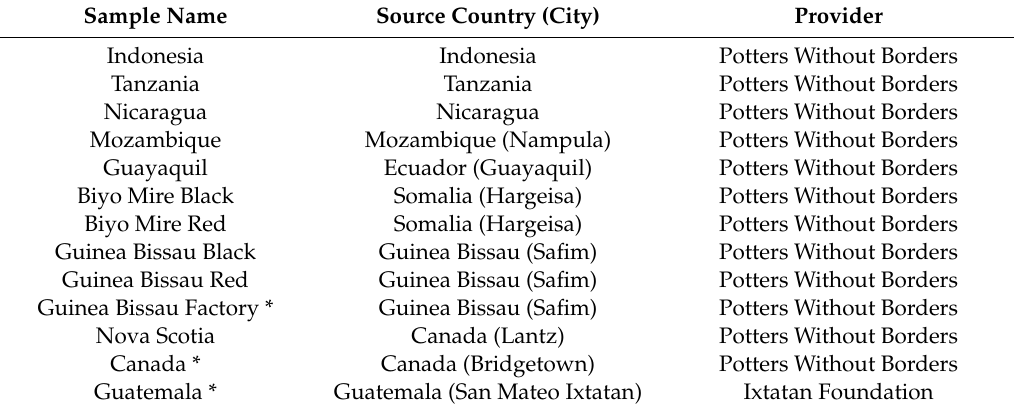
Table 1. Sources of clayey